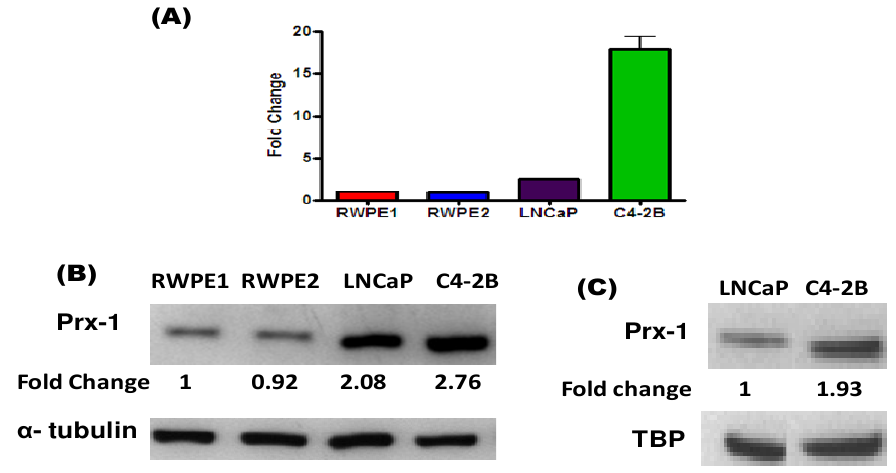
Figure 5. Prx-1 Expression in a Model of PCa Progression. (A) qRT-PCR and ( B) total lysate westerns for Prx-1 in our panel of PCa progression. Data are normalized to GAPDH and α - tubulin respectively. (C) Nuclear Prx-1 protein levels in LNCaP and C4-2B cells are shown. Data are normalized to nuclear TBP levels.